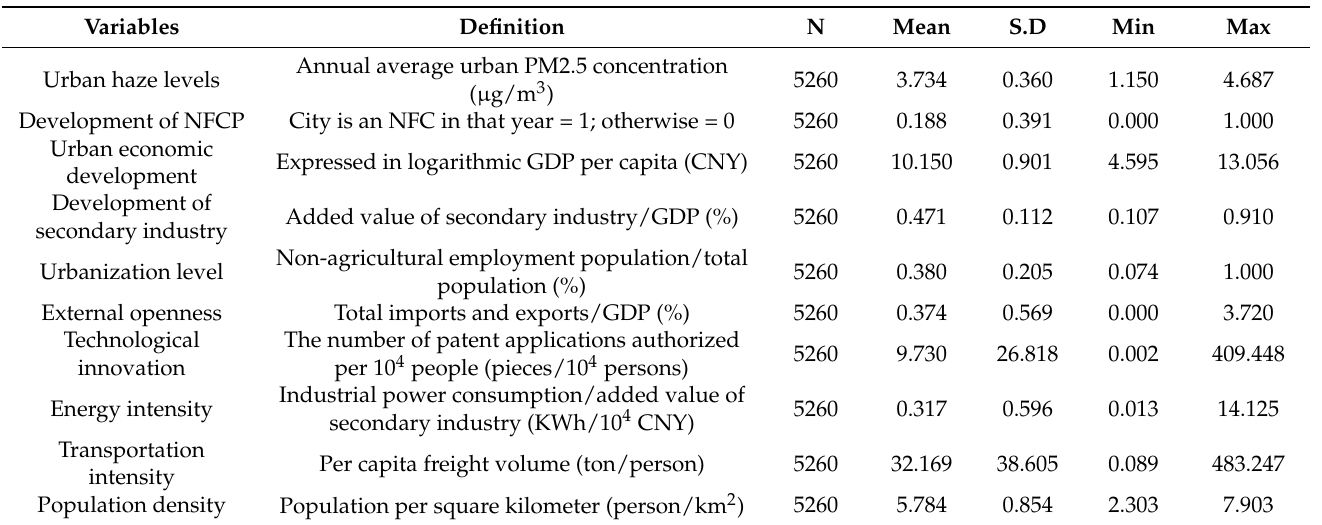
Table 1. Descriptive statistics of the